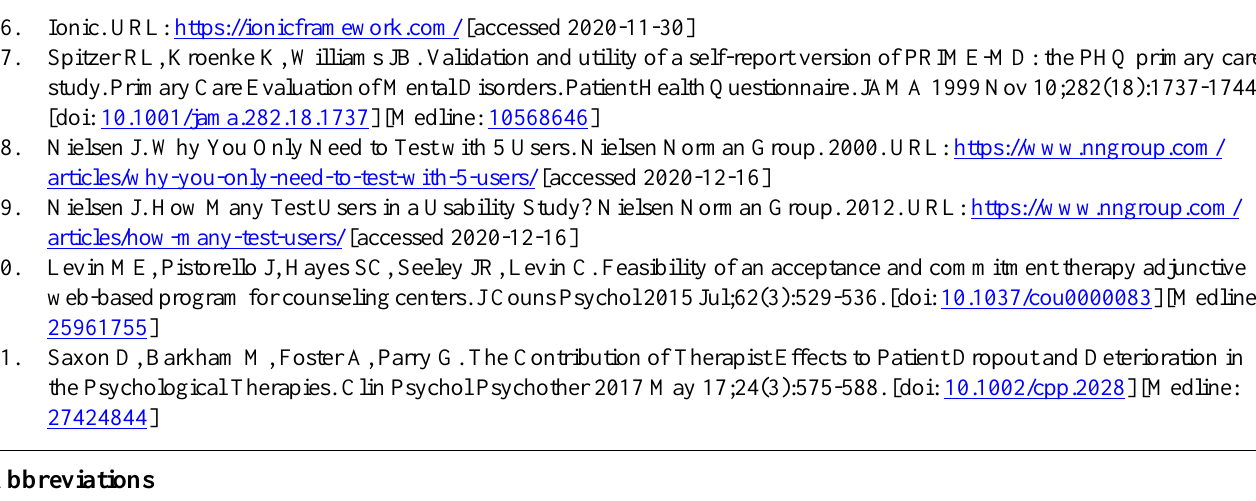
Abbreviations CAT: cognitive analytic therapy CBT: cognitive-behavioral therapy GDPR: General Data Protection